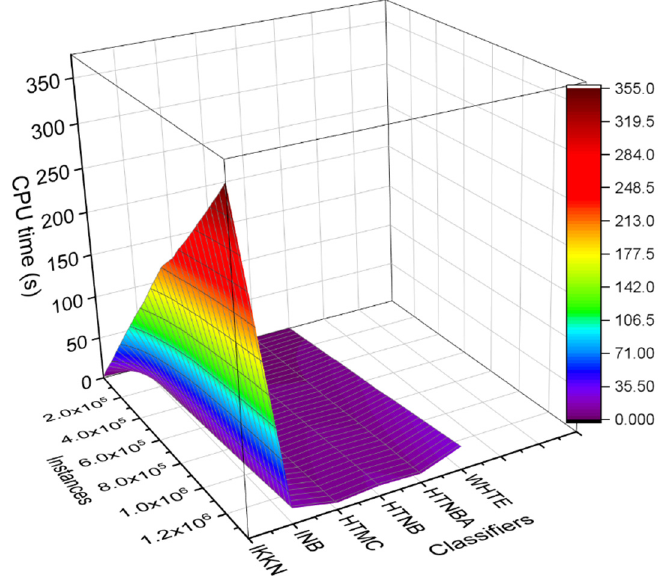
Figure 13. The 3D colormap surface compares the classifiers based on the CPU time for each subset of data samples per slide window in the NetFlow-ToNIoT dataset .